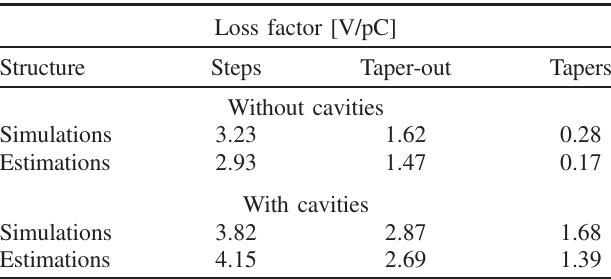
TABLE IV. The loss factor of different structures obtained with ABCI code. The loss factor of four single-cell cavities is κ ¼ 1 . 22 V = pC. The estimated values are given by Eqs. (13), 4 cav (12), and